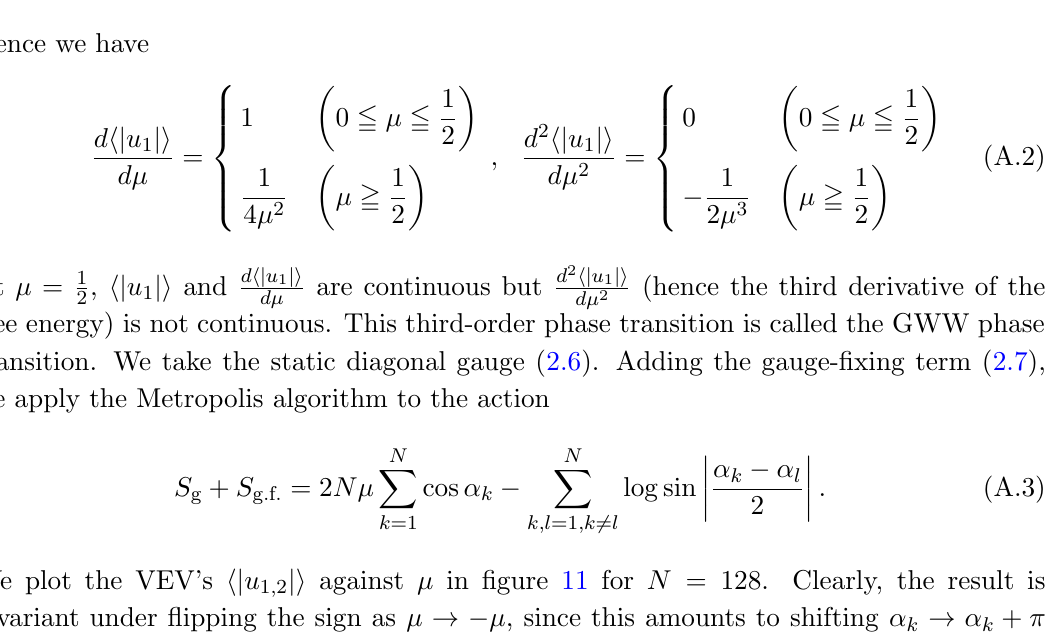
Figure 11 . V.E.V.’s hj u 1 ; 2 ji for N = 128 against (cid:22)